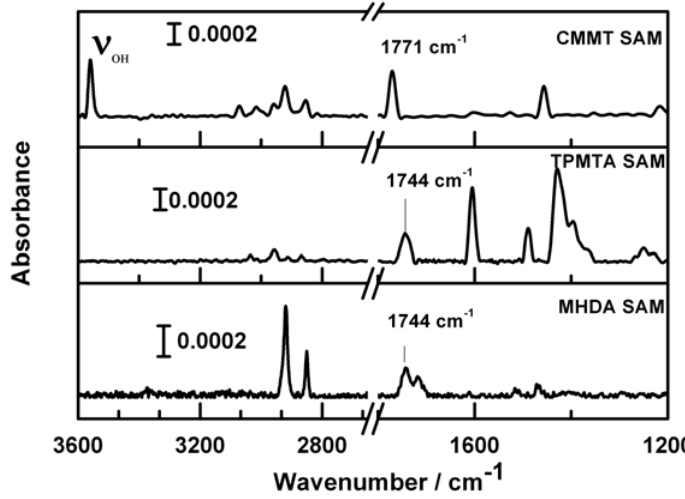
Figure 4. IRRA spectra of CMMT-, TPMTA- and MHDA-SAMs on